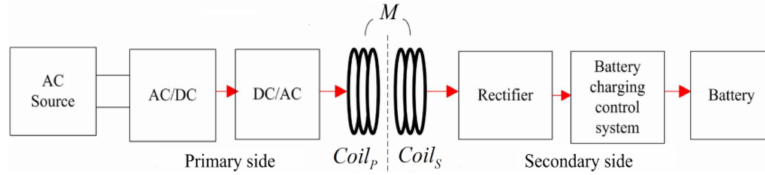
Figure 1. Inductive power transfer (IPT) system